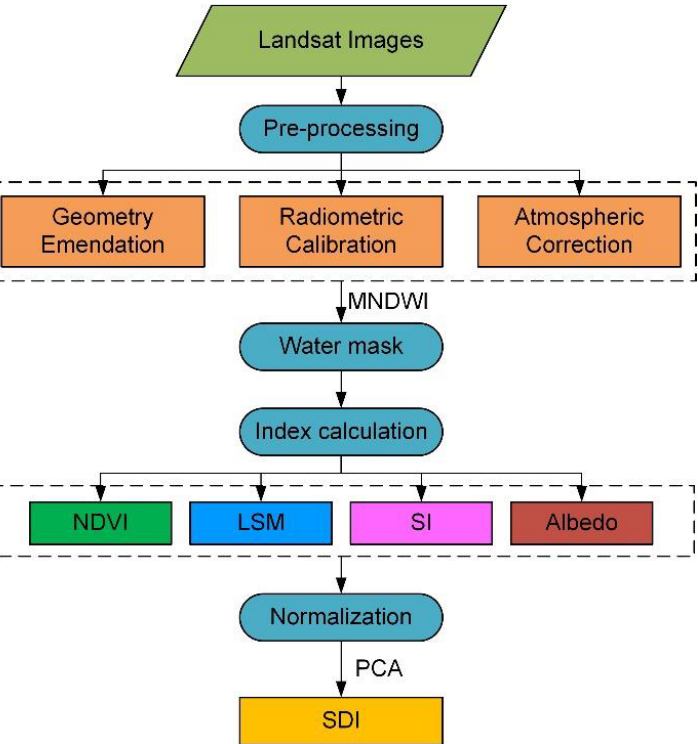
Figure 2. Flowchart of construction salinized land degradation index (SDI). MNDWI: modified normalised difference water index; NDVI: normalised difference vegetation index; LSM: land surface soil moisture index; SI, salinization index; PCA: principal component analysis; SDI: salinized land degradation index.